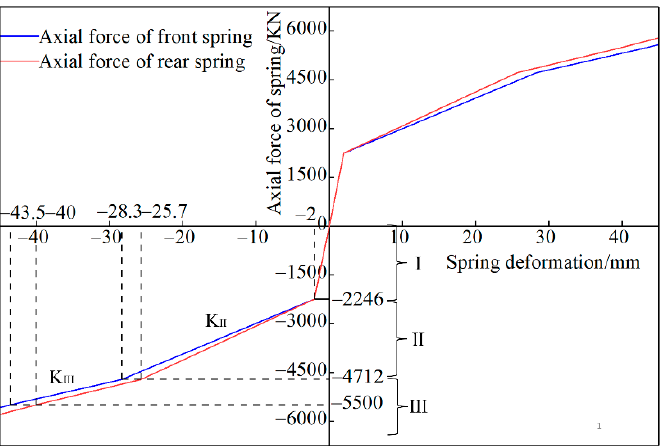
Figure 3. Axial force-deformation curve of spring.